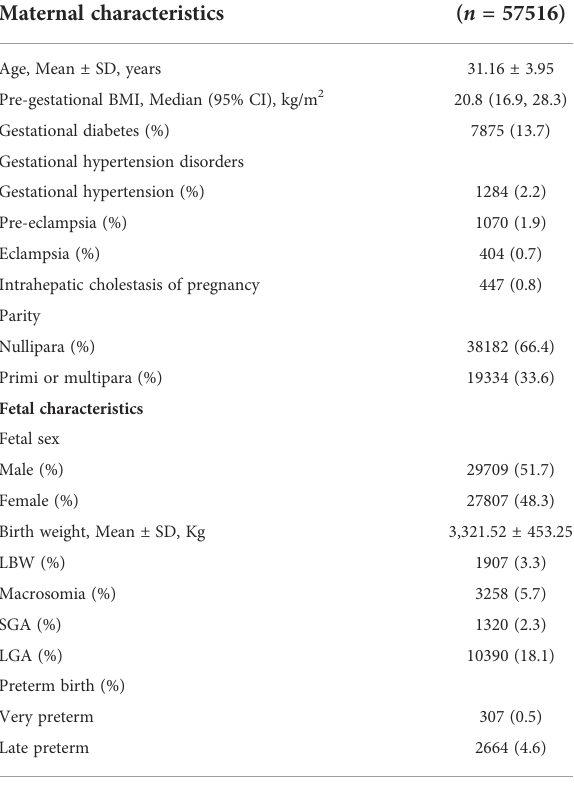
TABLE 1 Descriptive statistics of study population.